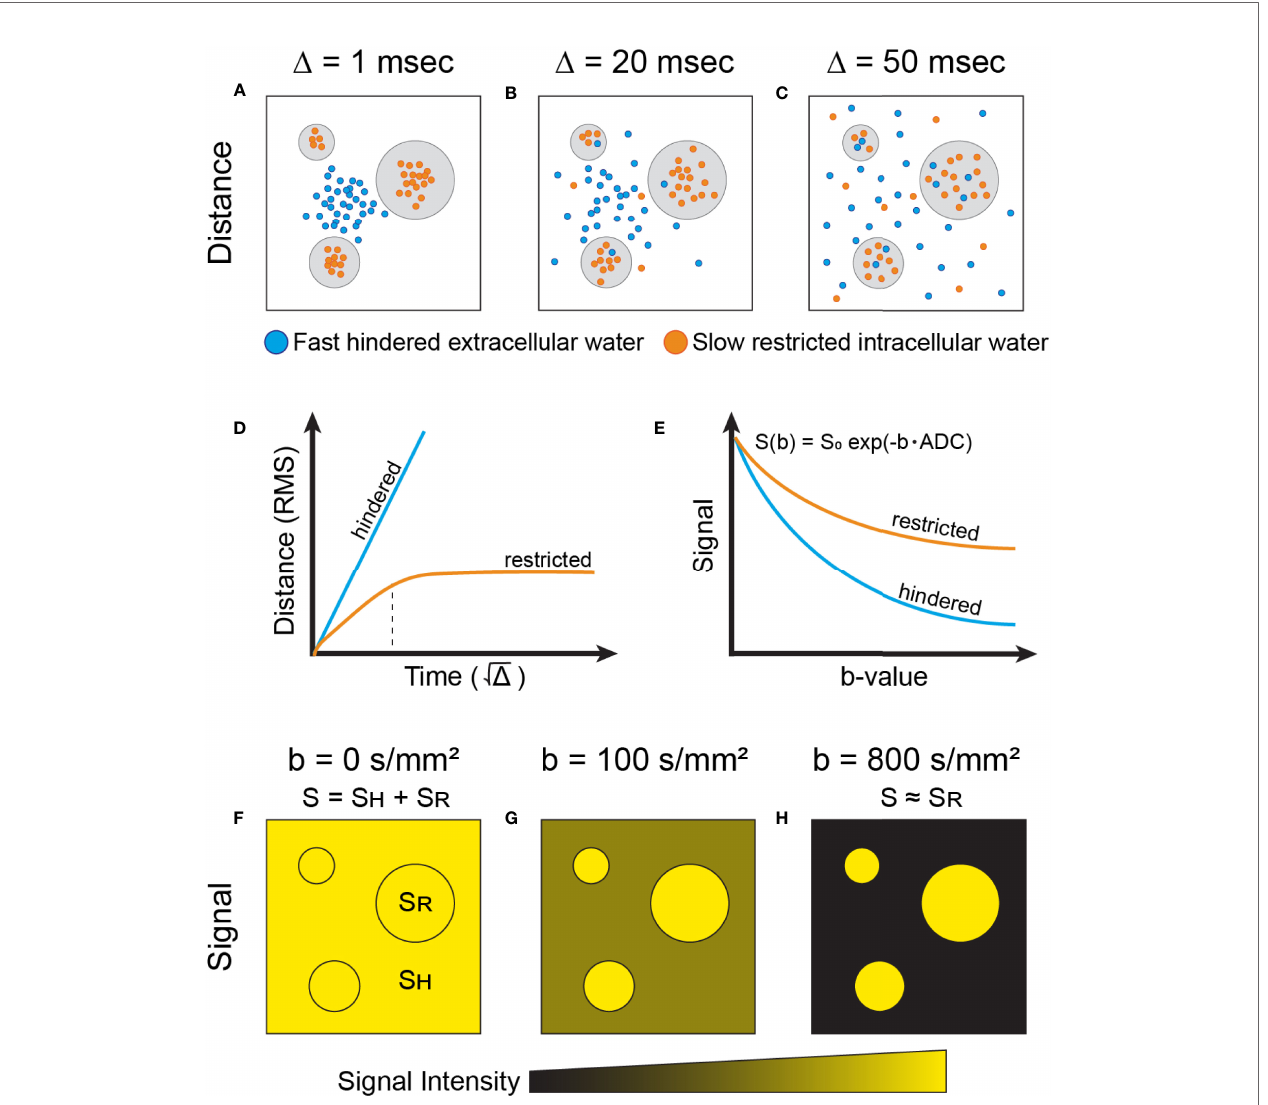
FIGURE 1 | Simpli fi ed physical basis of advanced diffusion imaging. Water molecules moving at two different speeds are shown: fast-moving (free and hindered) which exist in extracellular space (blue), and slow-moving (restricted) molecules that are trapped intracellularly by the plasma membrane (orange). Note that exchange between the extra- and intracellular compartments also exists, dictated by membrane permeability. The schematic shows the dispersion of these water molecular diffusing across cellular compartments, at different timescales ( D ) of (A) 1msec, (B) 20 msec, and (C) 50 msec. (D) The root mean square (RMS) distance of water ffiffiffi p D molecules experiencing hindered diffusion is linear with respect to the (i.e. Gaussian diffusion, blue). In contrast, slow-moving water molecules in the intracellular compartment display Gaussian diffusion behavior (linear) at very short timescales (panel D , orange), dictated by the compartment ’ s intrinsic diffusivity (5). At intermediary timescales, molecules reach the plasma membrane boundary that restricts movement, indicated by the dotted black vertical line. Past this, the net squared displacement becomes sublinear with time and is dependent on the dimensions of the compartment. To note, at very long diffusion timescales ( D >1s), restricted water diffusion becomes principally governed by the exchange rate between the intra- and extracellular compartments (5). (E) In DW-MRI, the measured signal (S) decays exponentially (in the case of Gaussian diffusion) with respect to b-value due to loss of spin coherence caused by dispersion of water molecules. Thus, the signal decay from water molecules experiencing hindered diffusion (blue) is faster than from water molecules experiencing restricted diffusion (orange). The measured diffusion signal at different b-value weighting (F – H) re fl ects the relative dephasing of water molecules in different tissue compartments. At short timescales (A, F), the measured signal, S, contains combined information from both hindered (S H ) and restricted (S R ) water signal. At progressively longer timescales (B, C, G, H) , signal from hindered water dissipates more quickly than that from restricted water due to increased motion along the diffusion gradient axis, and the measured signal begins to arise predominantly from the restricted water signal (5). As shown in panel (E) , restricted water will retain more signal at higher b-values than hindered water and, correspondingly, have a lower ADC than hindered